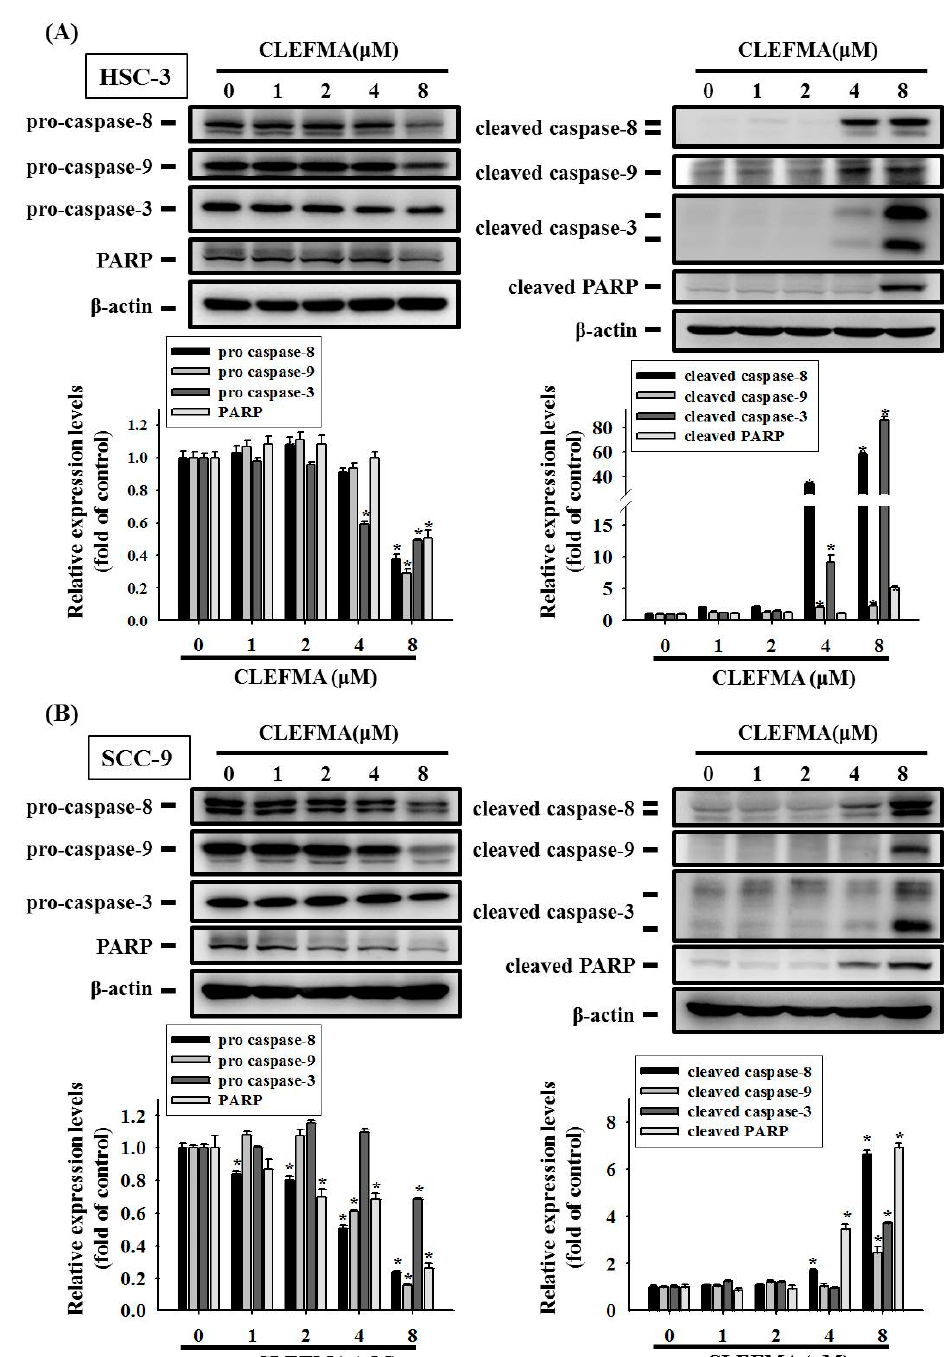
Figure 5. Apoptotic patterns of OSCC cells treated with CLEFMA. ( A ) HSC-3 and ( B ) SCC-9 cells were treated with 0–8 µ M CLEFMA. Western blot analysis was performed. β -actin was used as a loading control. Proteins signals were visualised with an ECL imaging system. Quantitative analyses were obtained from three independent experiments and expressed as mean ± SD. * represent p < 0.05 as compared with the control.